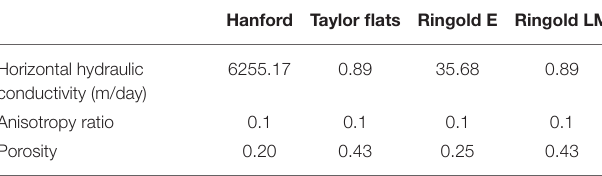
TABLE 1 | Hydrogeologic properties of geologic